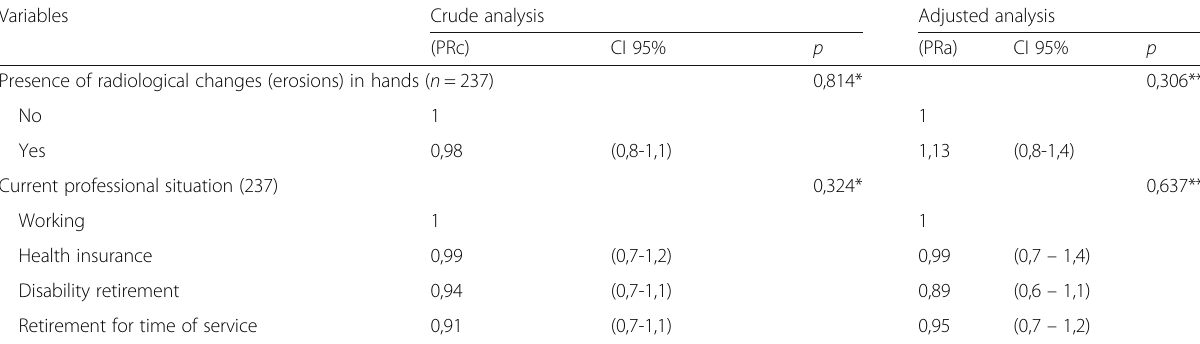
Table 2 Crude and adjusted regression analysis of diagnostic time up to 3 months and independent variables in patients with rheumatoid arthritis in Blumenau, Santa Catarina, Brazil, 2014